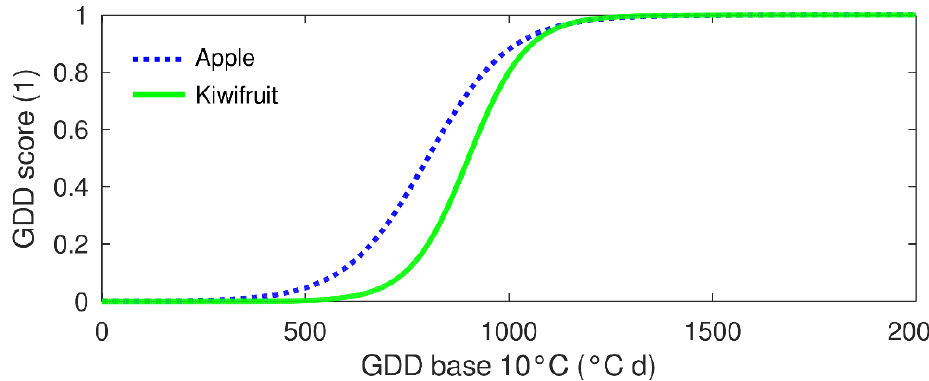
Figure 3. Growing degree days (GDD) score assigned to different GDD values base 10 °C. A higher score indicates GDD accumulation is more likely to achieve sufficient fruit growth and maturation.